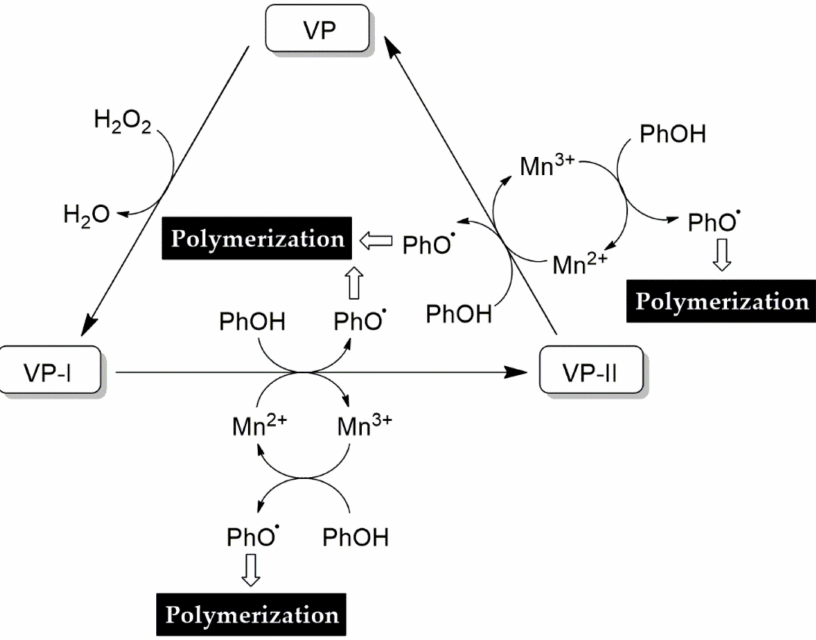
Figure 12. Scheme of the versatile peroxidase catalytic cycle